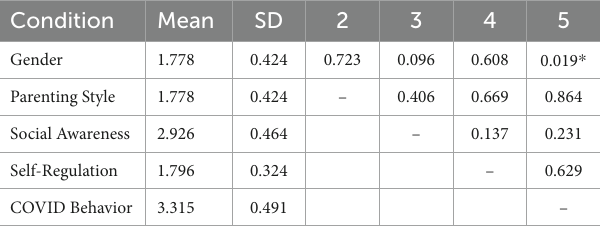
Table 2 for White participants, Table 3 for Other race participants, and Table 4 for African American/Black participants. For Gender, Male = 1 and Female = 2, and for Parenting Style, Authoritarian = 1 and Authoritative = 2.